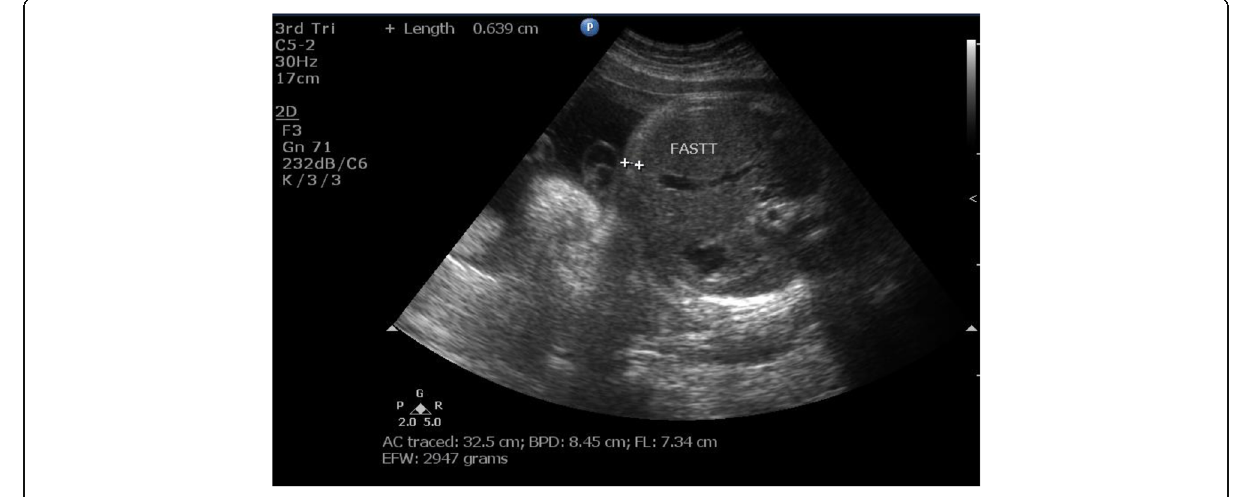
Fig. 1 FASTT measurement at EFW 2947